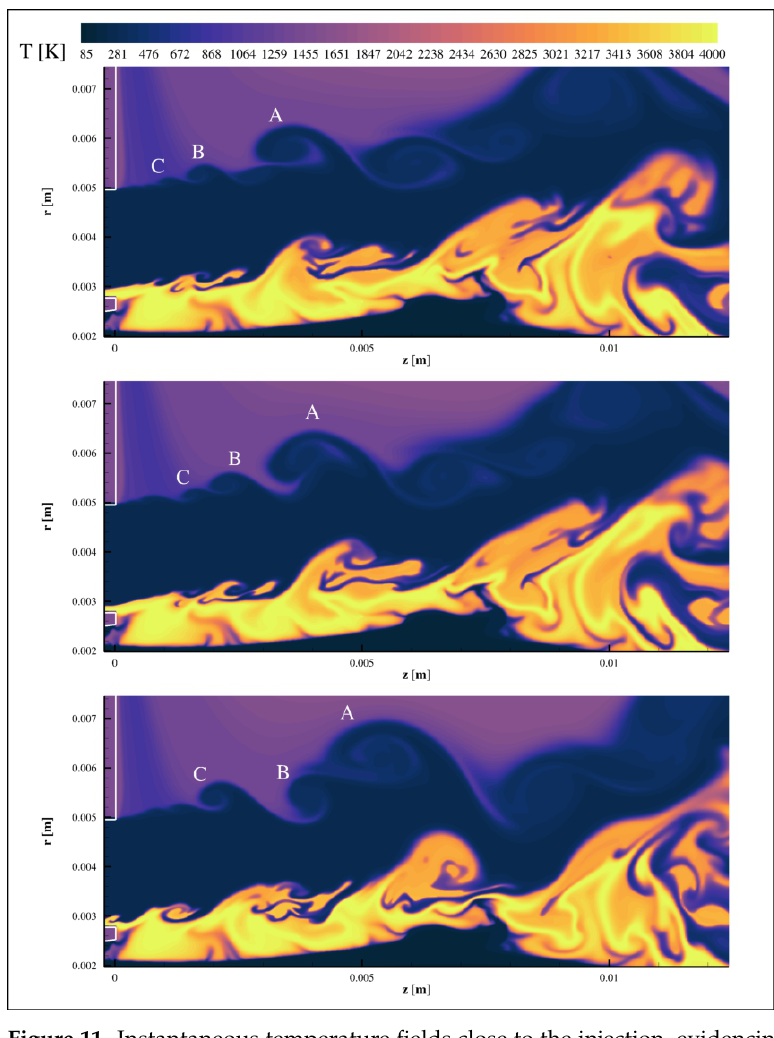
Figure 11. Instantaneous temperature fields close to the injection, evidencing the inner and outer shear-layers; three coherent structures are marked with the labels A, B, C. The delay time between each frame (from top to bottom) is ∼ 5.74 µ